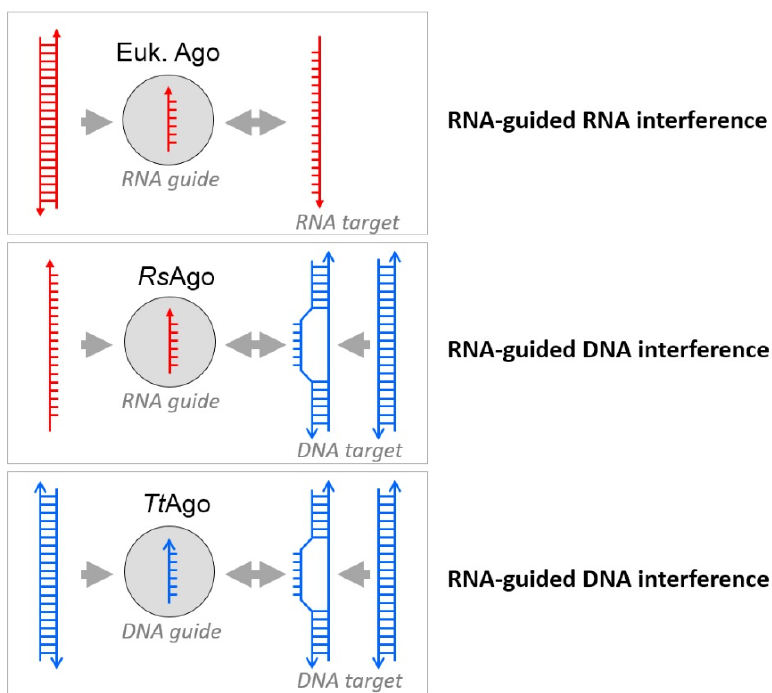
FIGURE 1: Prokaryotic variations of the eukaryotic RNAi theme. Eukaryotic Argo- nautes acquire short RNA guides to target complementary RNA molecules, resulting in silencing of expression of the corre- sponding gene; in case the Argonautes possess an intact active site, this will result in nucleolytic cleavage of the target RNA. Two types of prokaryotic Argonautes have recently been characterized. The RsAgo acquires guides from plasmid-derived mRNA, that allow binding of the comple- mentary DNA strand of a plasmid; as RsAgo is inactive (*), it requires an additional nucleolytic enzyme for target cleavage. On the contrary, the active TtAgo acquires small DNA guides (mainly from plasmids) that allow for binding and cleavage of plasmid DNA